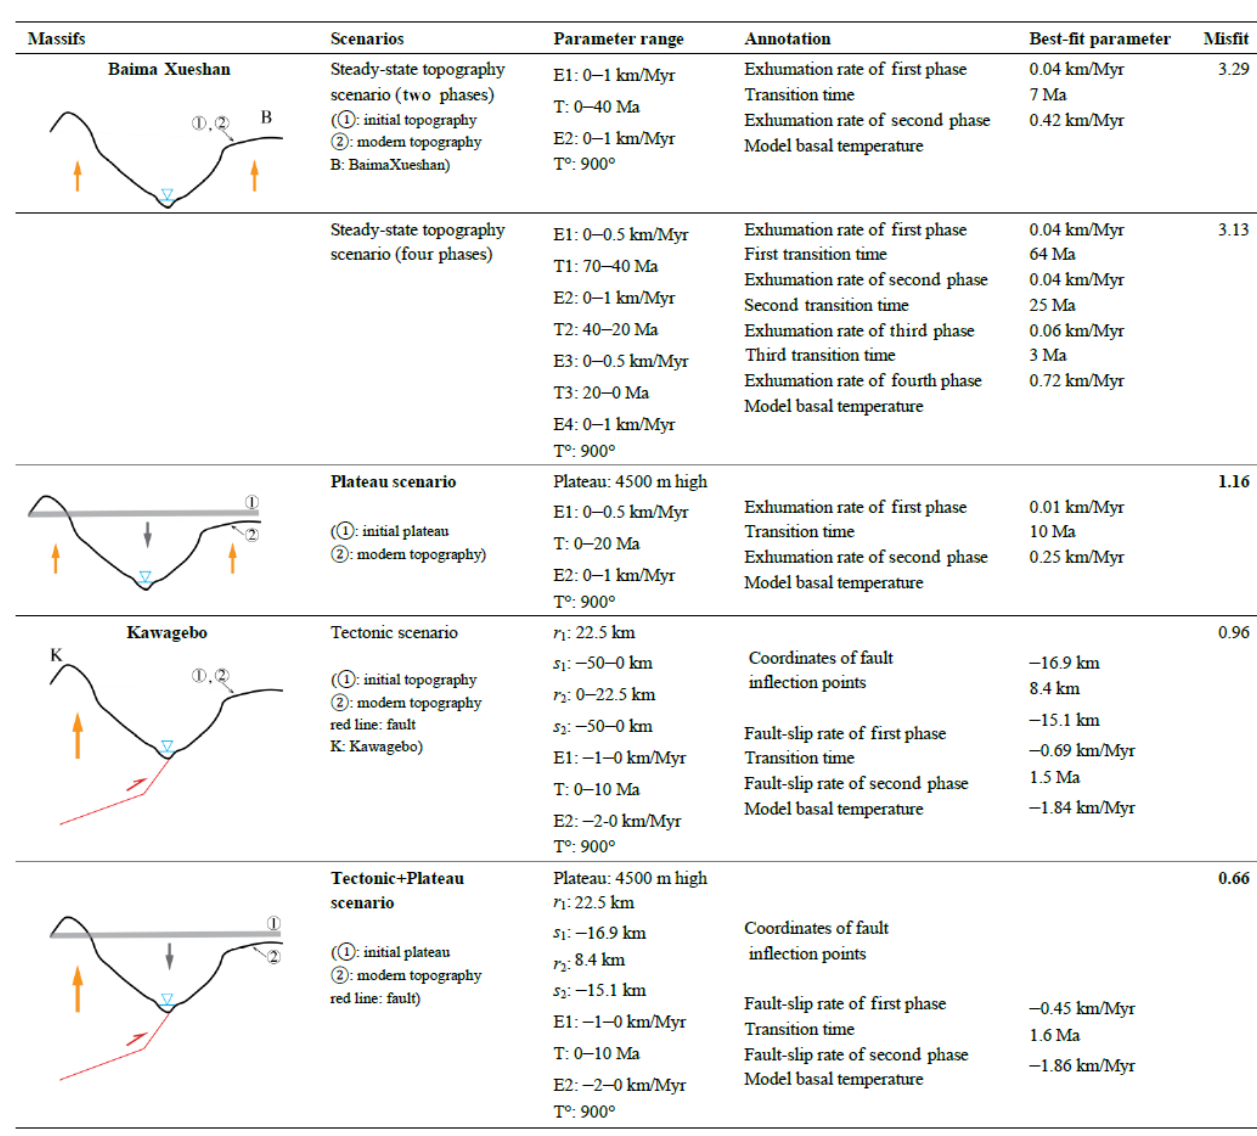
Table 2. Inversion parameters for the different scenarios tested for the Baima Xueshan and Kawagebo massifs. The best-fit scenario, with the lowest misfit for each massif, is in bold. A range of exhumation rates is explored for different phases, separated by transition times. Coordinates of the fault inflection points define the geometry of the fault plane, with r i and s i (in km) corresponding to the depth and distance relative to the surface trace of fault, respectively. Note that the tectonic scenario includes a slip rate on the fault rather than a vertical exhumation velocity and that upward slip on a thrust is indicated by negative values (see Braun et al., 2012, for more